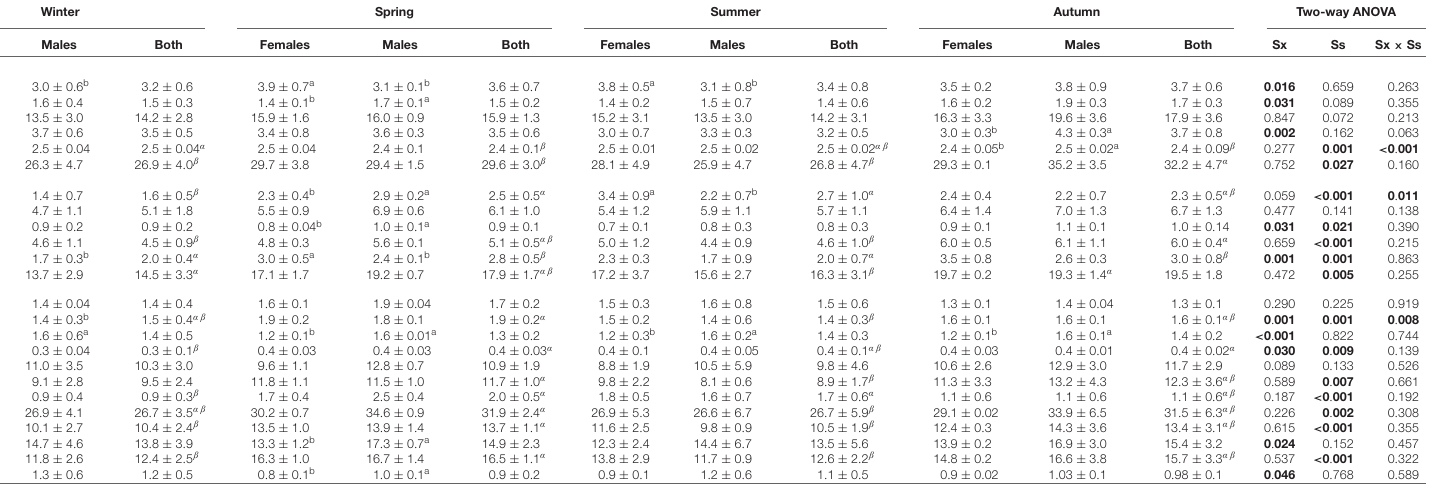
TABLE 3 | Fatty acids (mg/g DM) profile and ANOVA results of Sphaerechinus granularis from Madeira archipelago. Winter Spring Summer Autumn Two-wayANOVA Females Males Both Females Males